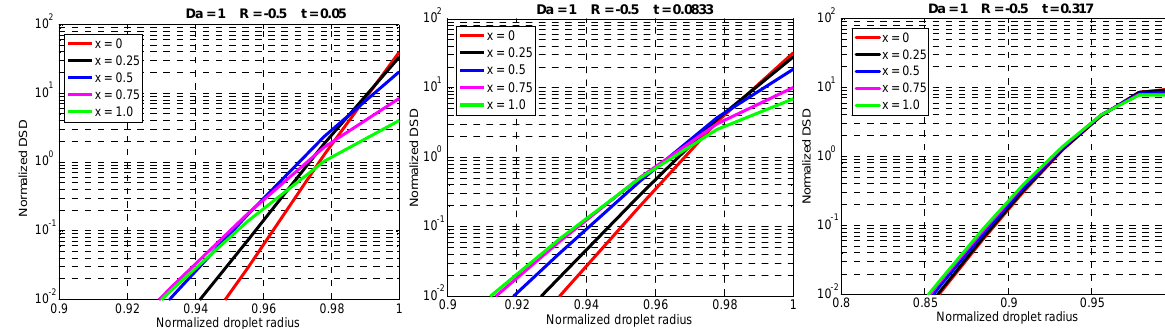
Figure 12. DSD at different e x at the beginning of the mixing process for Da = 1 and R = − 0 . 5.